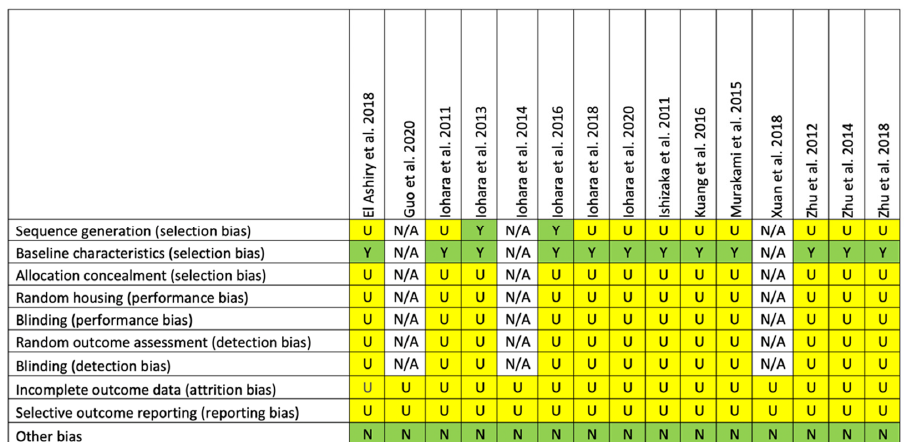
Figure 2. Risk of bias assessment for the included animal studies. N/A indicates that there was only one group. U: unclear; Y: yes; N: no.